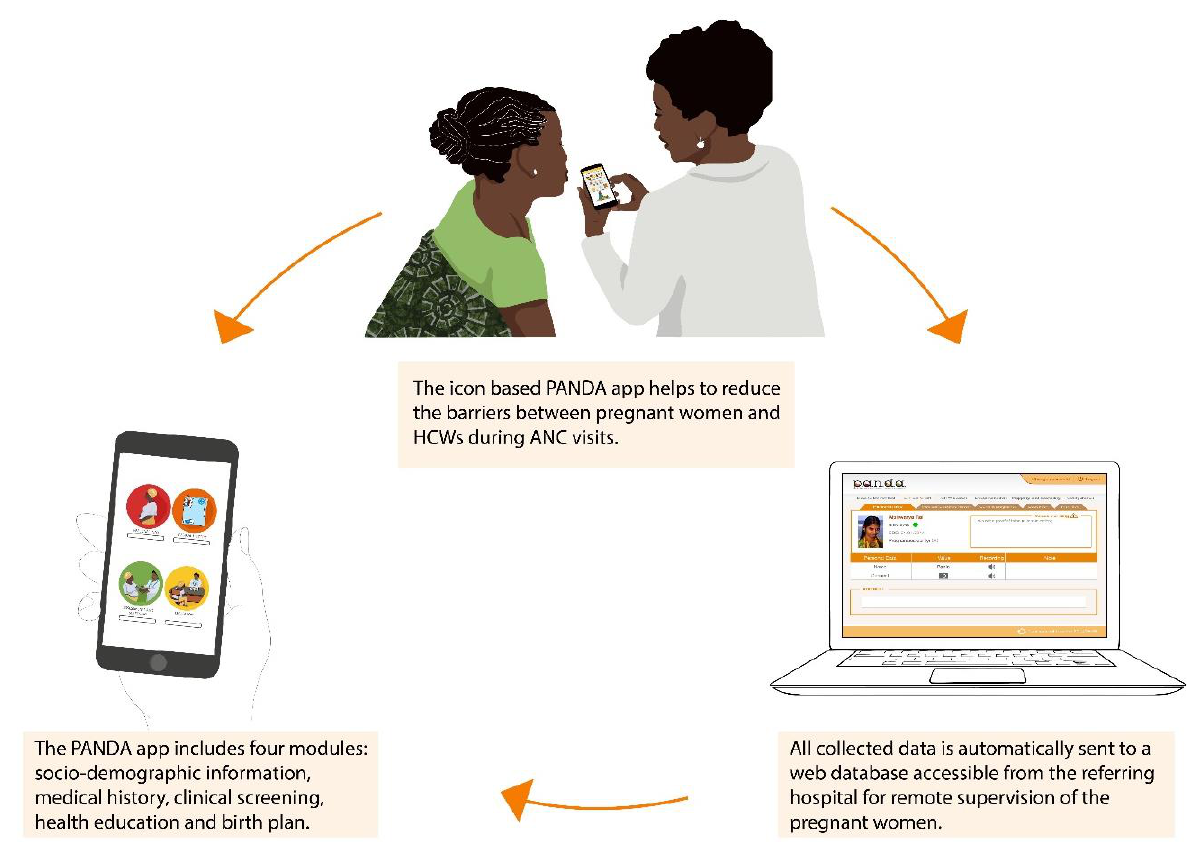
Figure 1. The PANDA system structure.